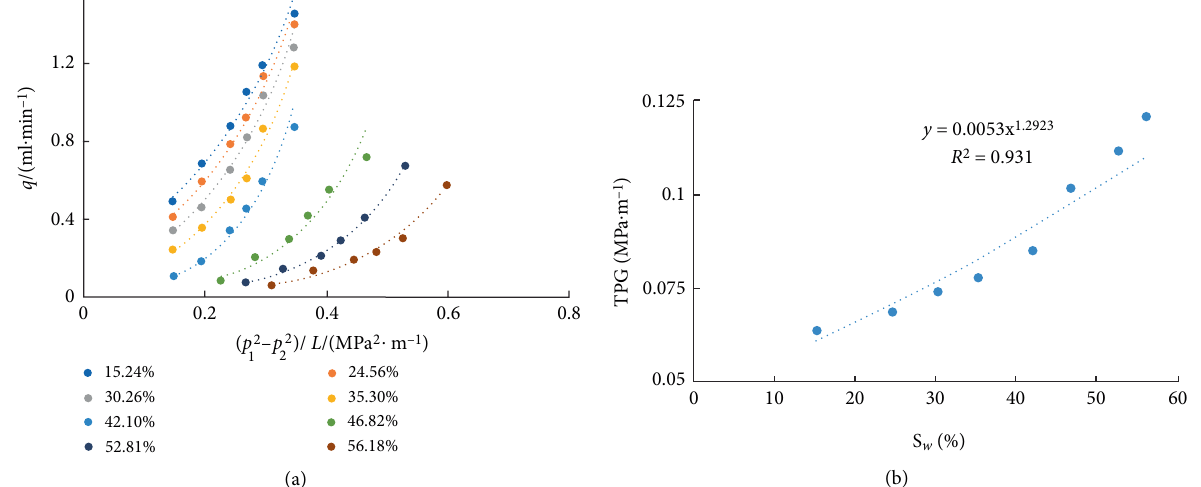
Figure 5: (a) Relationship between gas flow rate and pressure square difference under different water saturation. (b) The correlation between water saturation and